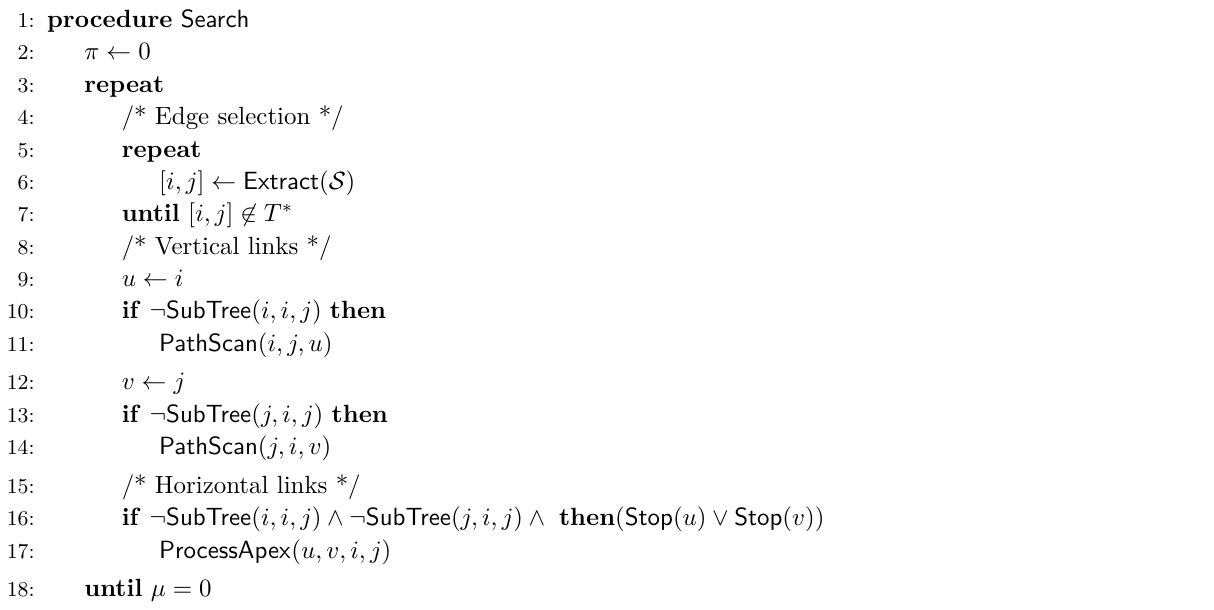
Algorithm 8 The procedure that detects all alternative